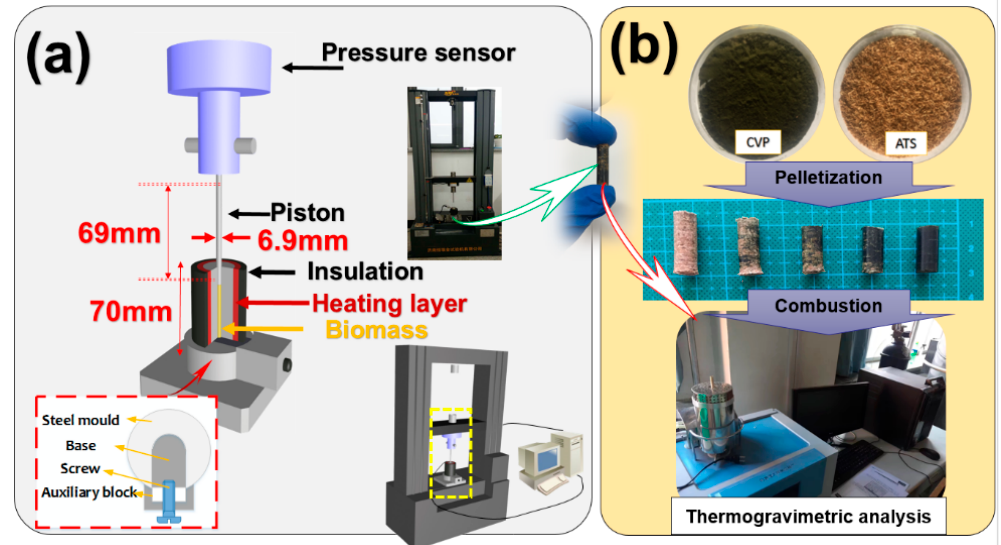
Figure 1. ( a ) Single pelletization experimental device and ( b ) TGA sample preparation process.